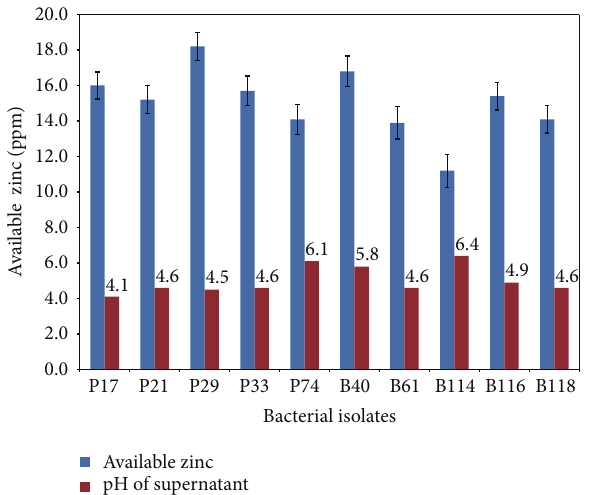
Figure 3: Available zinc (mg ⋅ kg −1 ) released by bacteria in broth medium containing zinc